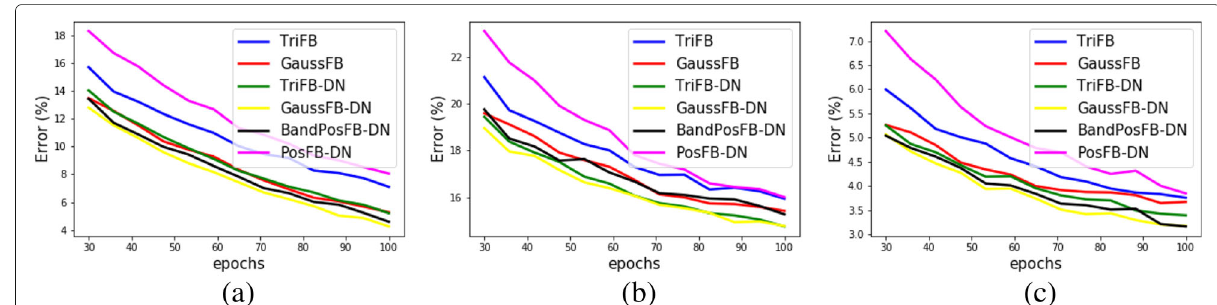
Fig. 8 Training and validation curves on LITIS ROUEN dataset. a 1 s clip classification error on training set. b 1 s clip classification error on validation set. c 30 s audio classification error on validation set